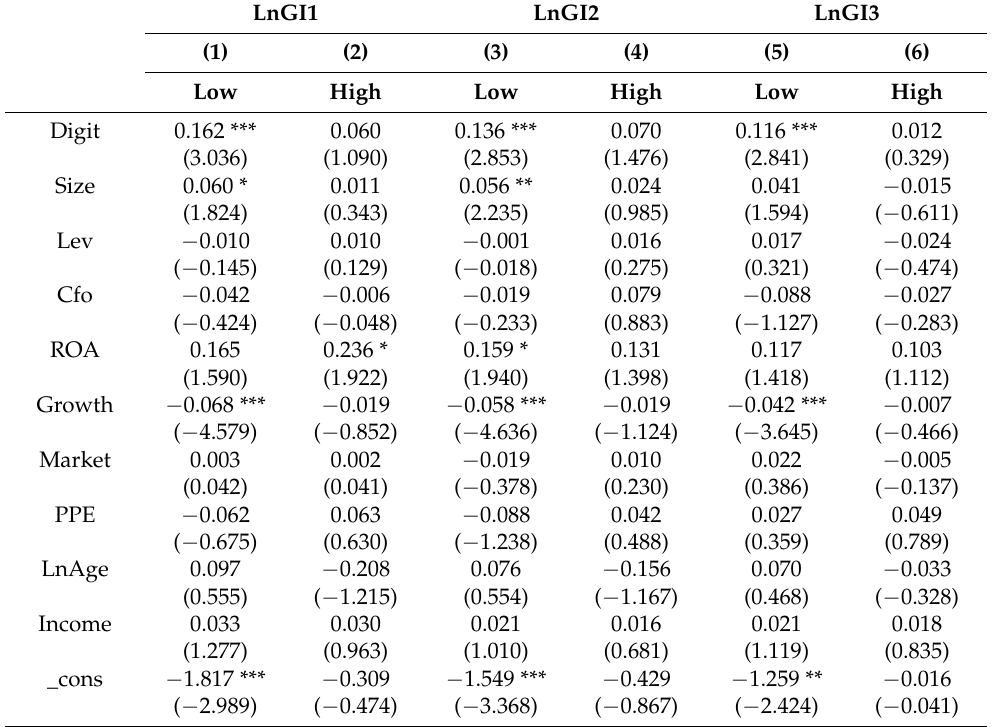
Table 9. Heterogeneity test for the industry